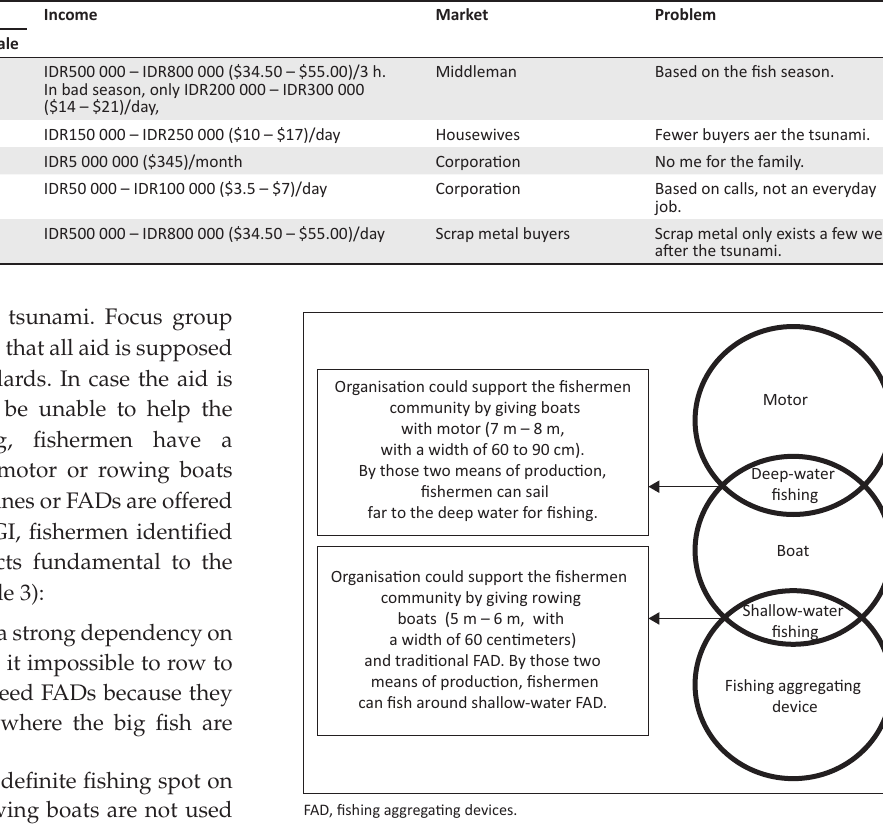
FAD, fishing aggregating devices. FIG URE 2: Venn diagram of best recovery aid for fishermen.